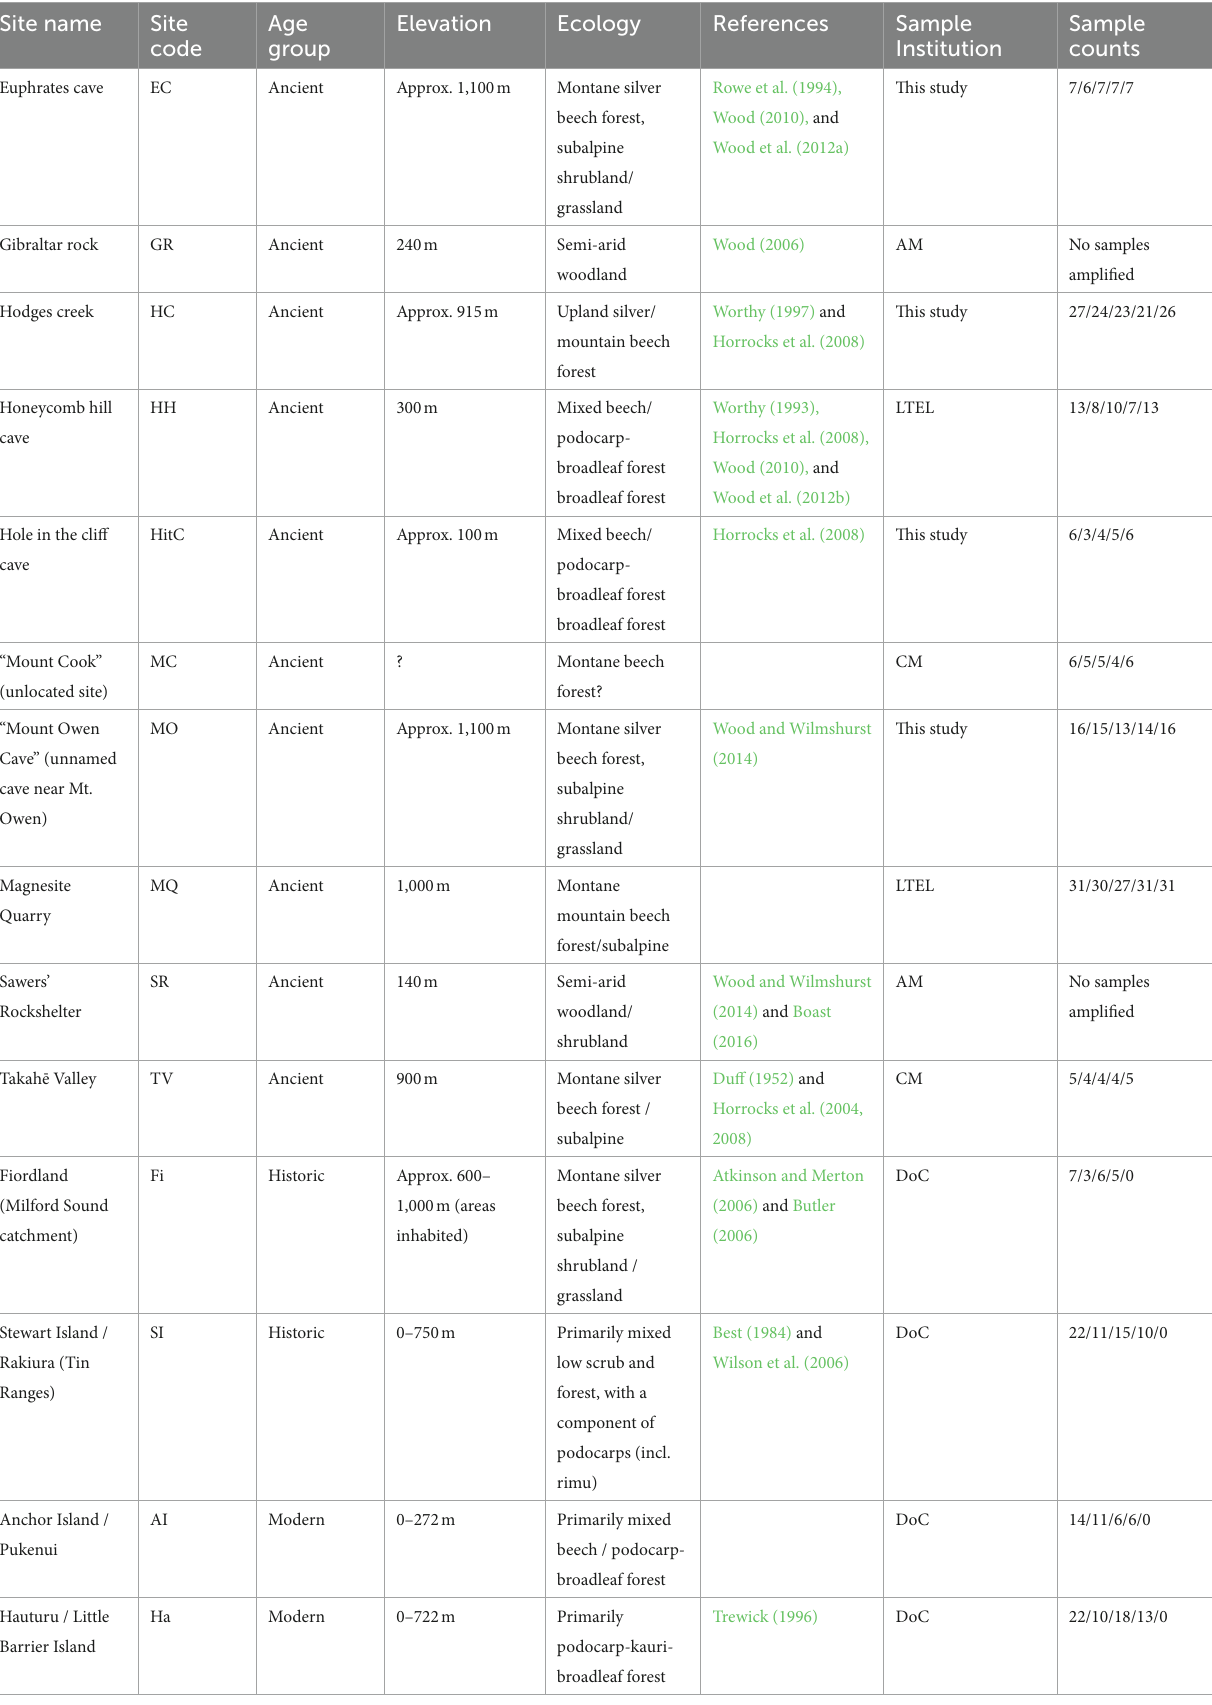
TABLE 1 Collection sites of samples in this study, sorted by age